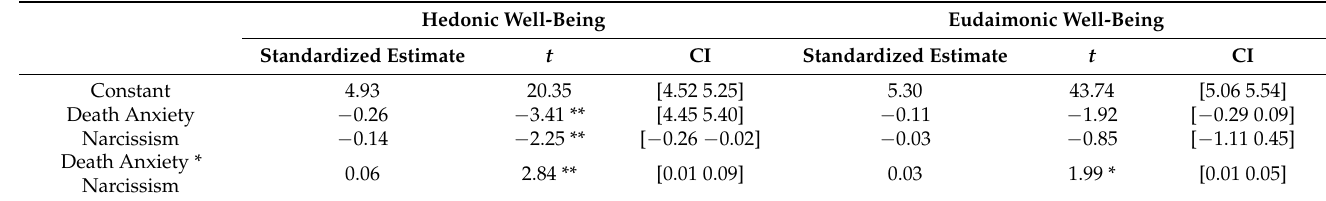
Table 2. Regression Model of Narcissism on Death Anxiety and Well-being ( n = 705). Hedonic Well-Being